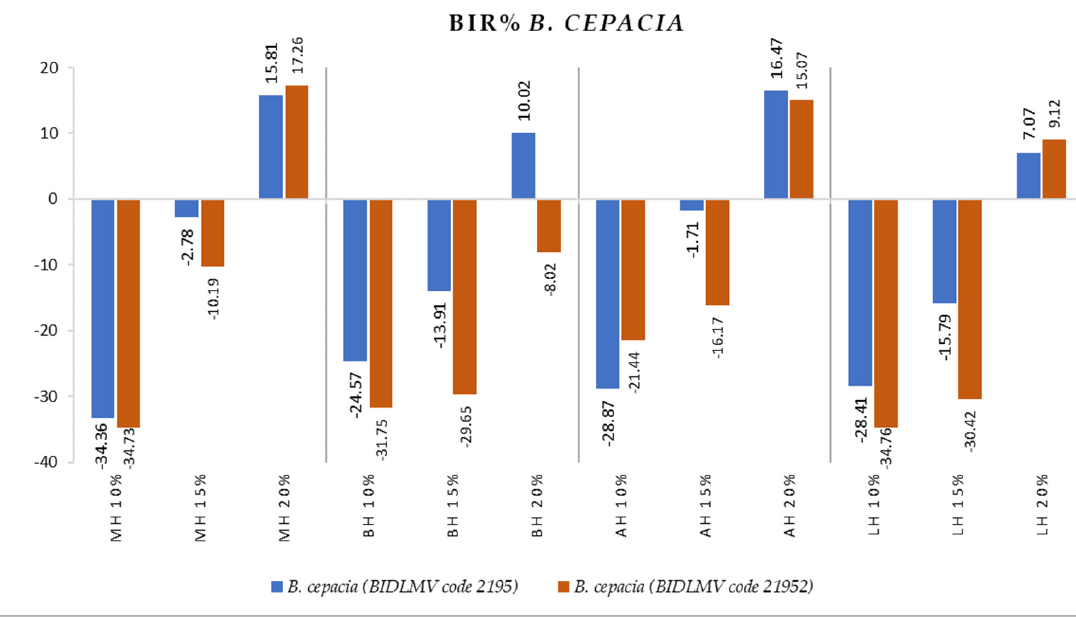
Figure 9. Antimicrobial activity (expressed as BIR%) of honey samples tested on B. cepacia isolates.